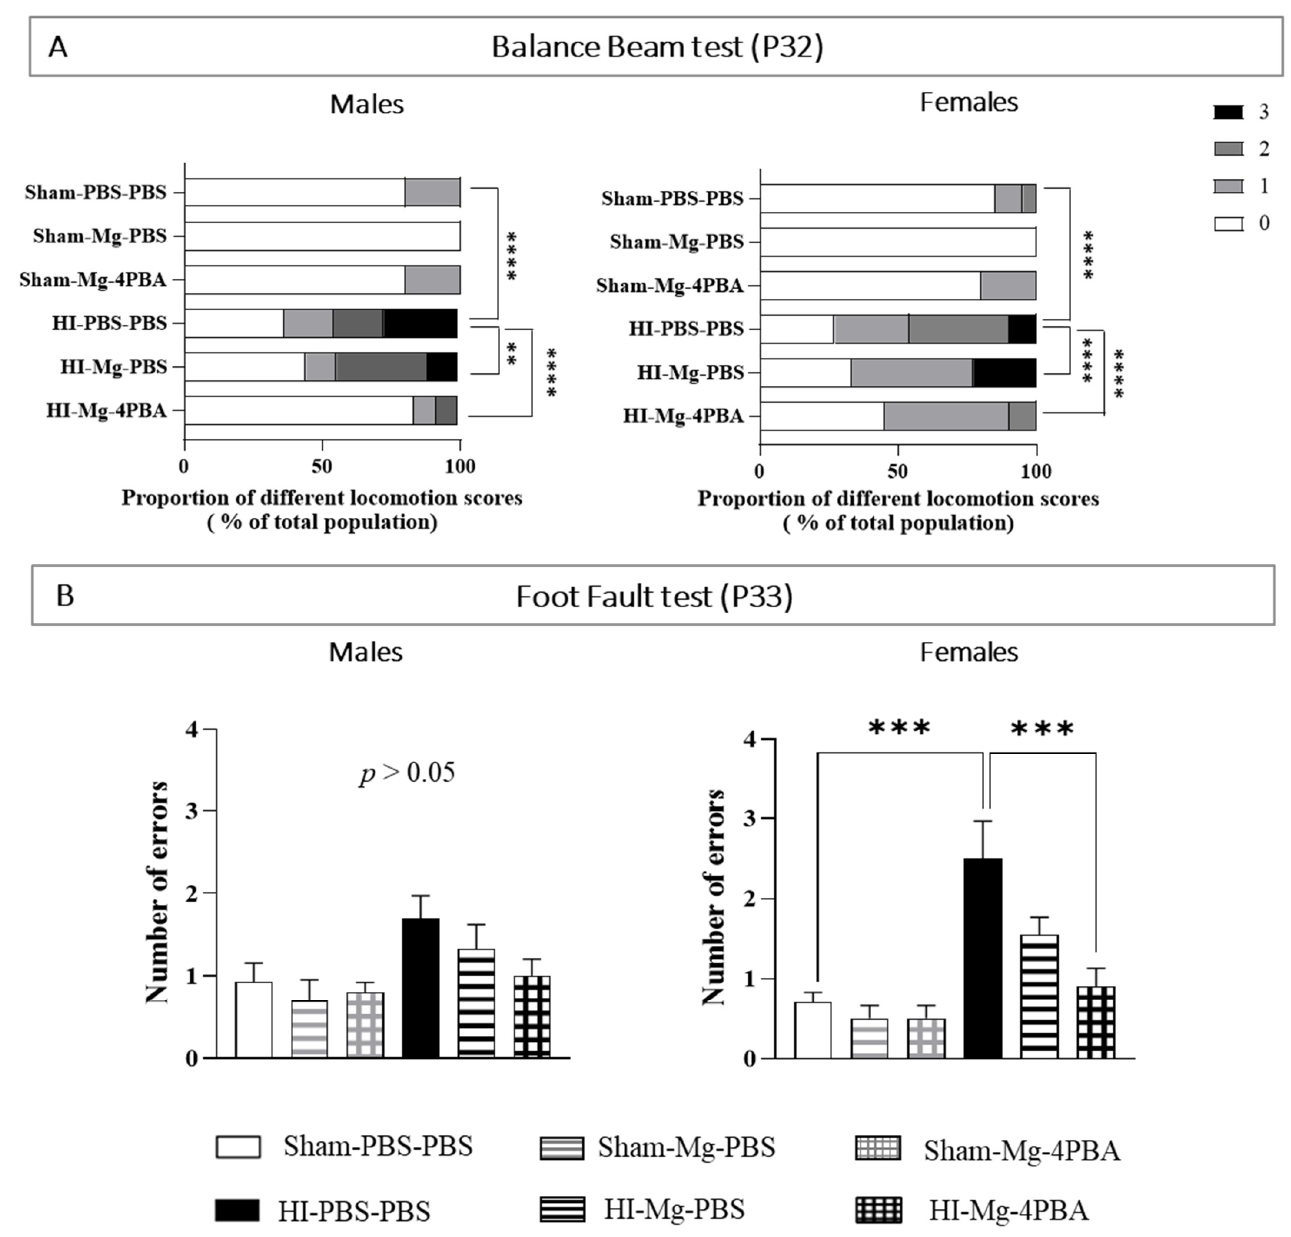
Figure 2. Effects of neonatal HI, MgSO 4 or of the MgSO 4 /4-PBA association on motor abilities in adolescent male and female mice. ( A )—Scores of locomotion in the balance beam test performed at P32. Data are expressed as proportion of scores. n = 5–14 males and 5–20 females/group. Chi2 test was executed. ( B )—Number of errors on the foot-fault test performed at P33. Data are expressed as M ± S.E.M. n = 5–14 males and 5–20 females/group. Two-way ANOVA was performed followed by Tukey’s post-test (** p < 0.01, *** p < 0.001; **** p < 0.0001).